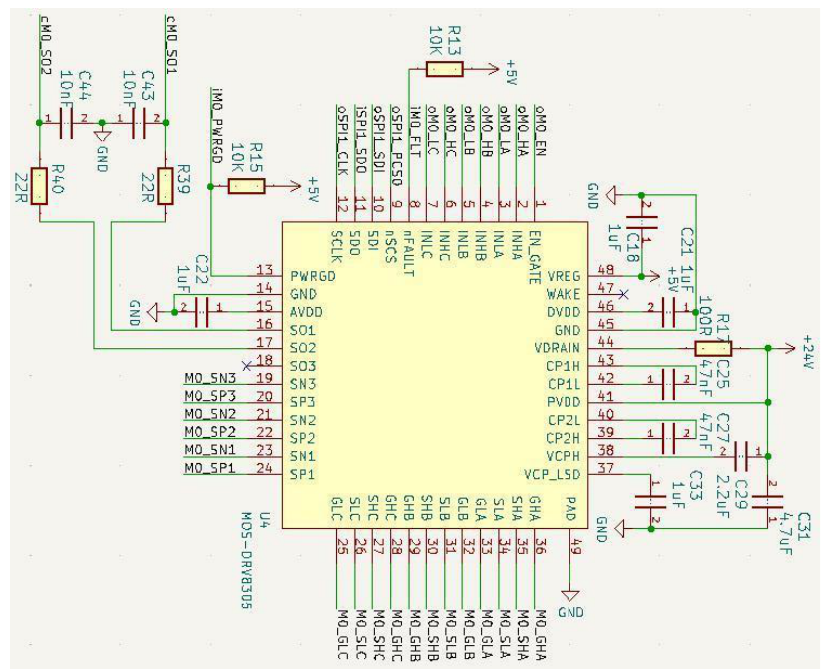
Figure 8. DRV8305N circuit schematic diagram.